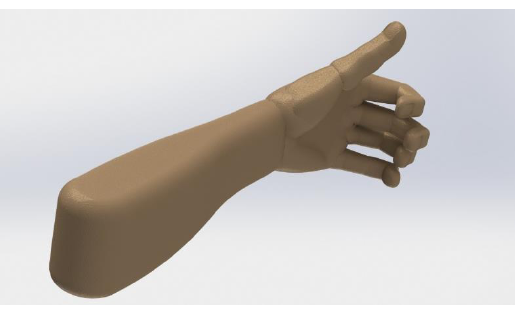
Figure 10. Simulated human arm.